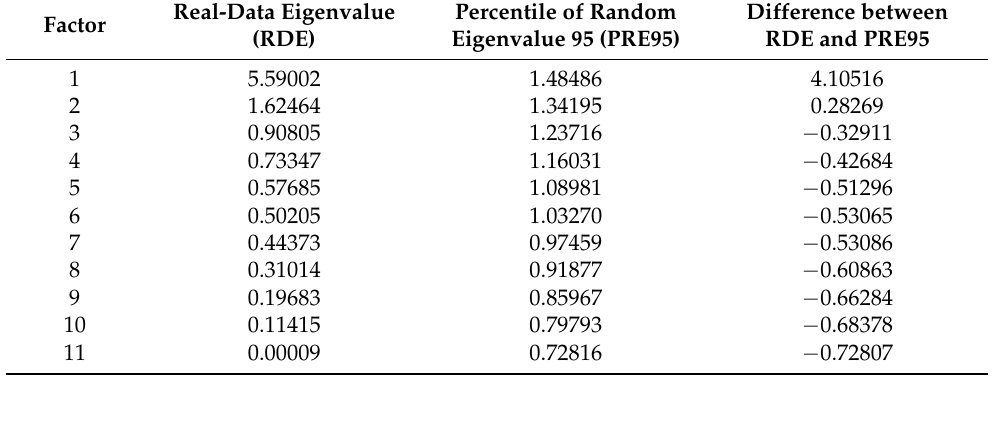
Table 1. Factors for real and simulated data.